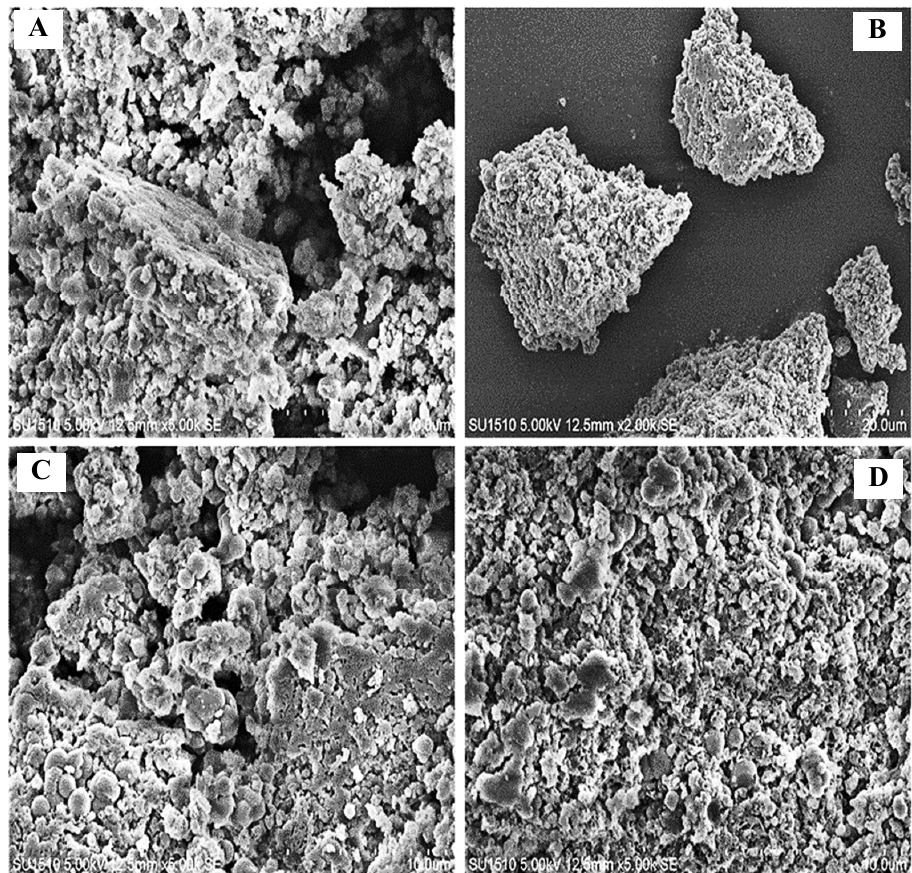
Figure 7. SEM images of the extracted melanin produced by G. oxydans FBFS 97. The aggregates of small spheres of the extracted melanin by G. oxydans FBFS 97 ( A – D ).